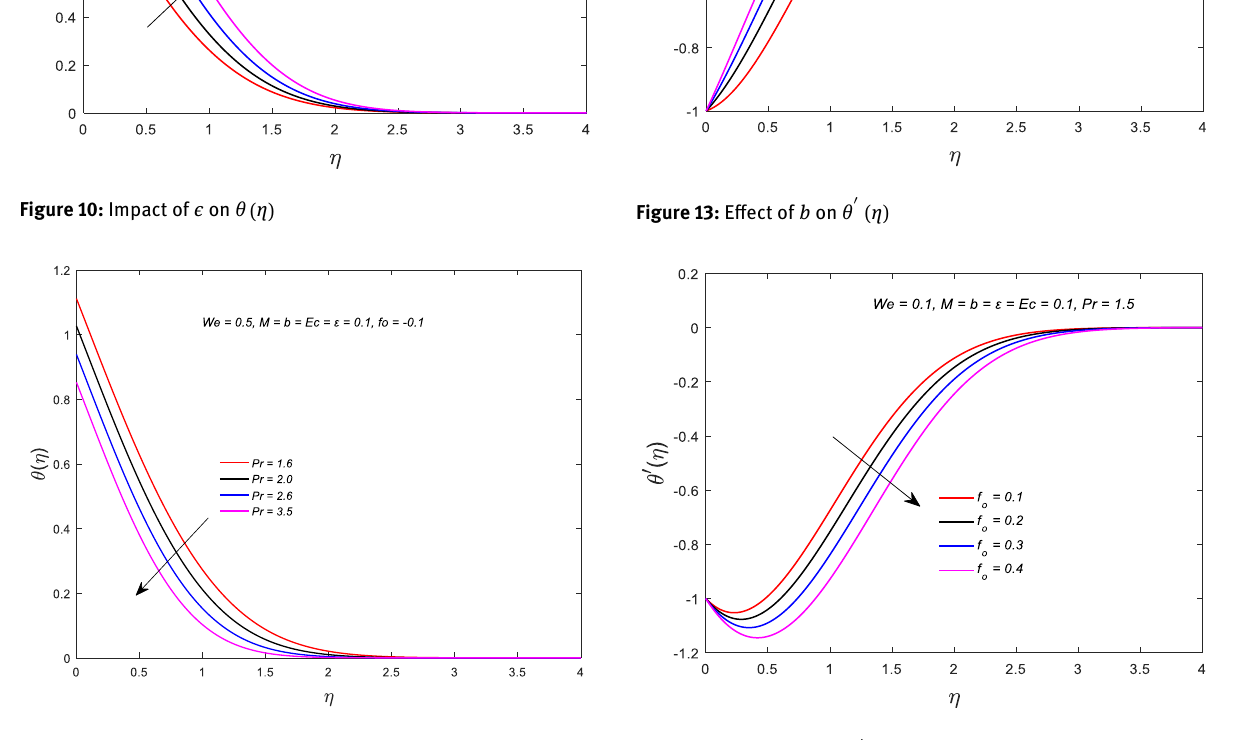
Figure 11: Effect of Pr on θ ( η )